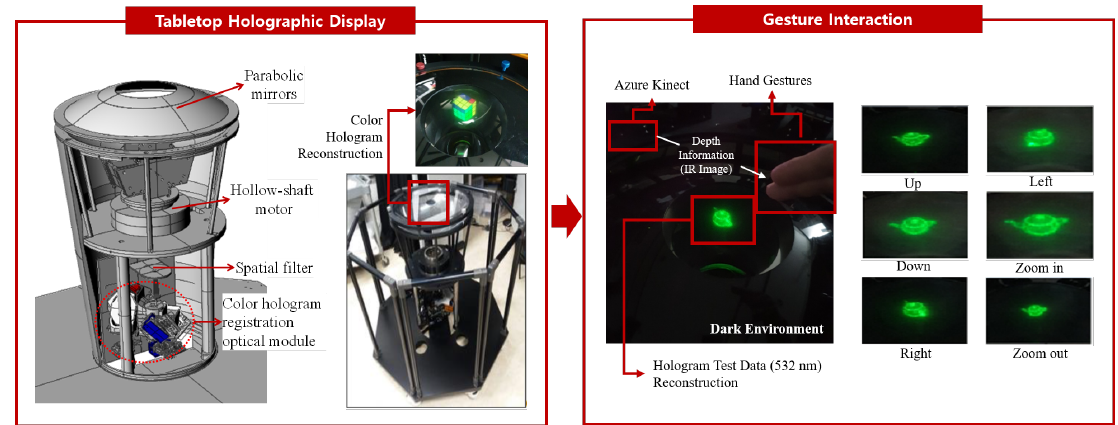
Figure 1. Overview of the gesture recognition for the tabletop holographic